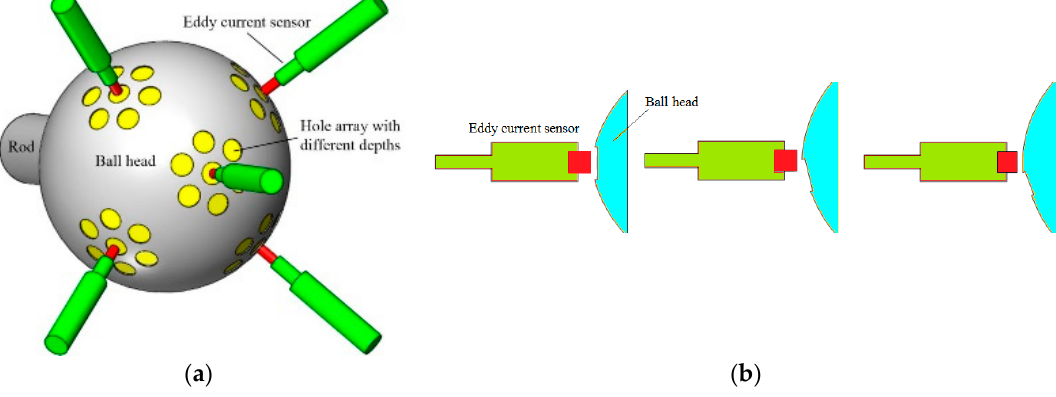
Figure 2. Measuring principle. ( a ) measuring principle; ( b ) working states of sensor.